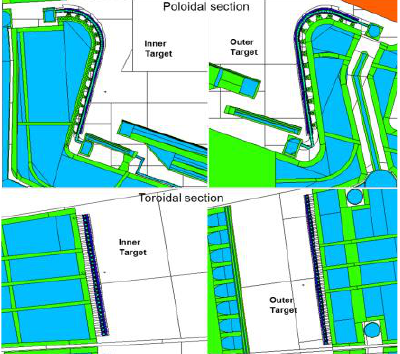
Figure 6. Fully heterogeneous IL PFCs inboard ( left ) and outboard ( right ) MCNP representation, poloidal section ( top ) and toroidal section ( bottom ).